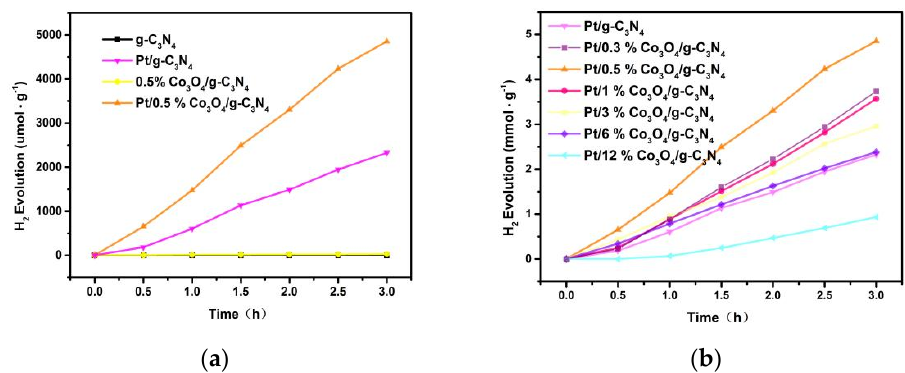
Figure 10. ( a , b ) Photocatalytic hydrogen evolution performance of prepared catalysts.